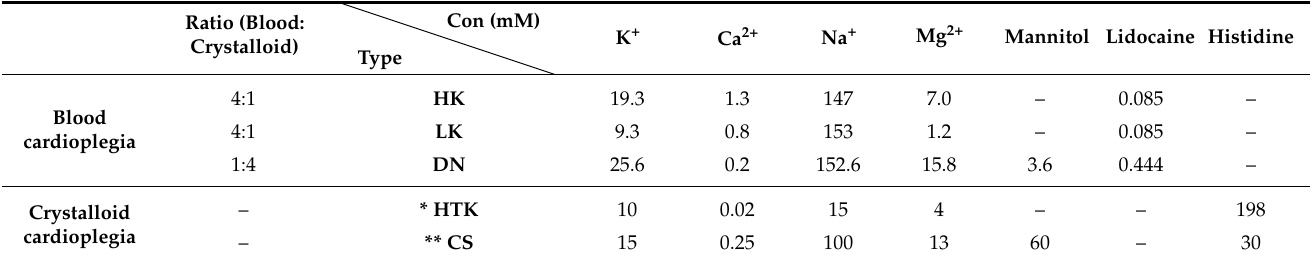
Table 1. Key Components of Common Cardioplegic